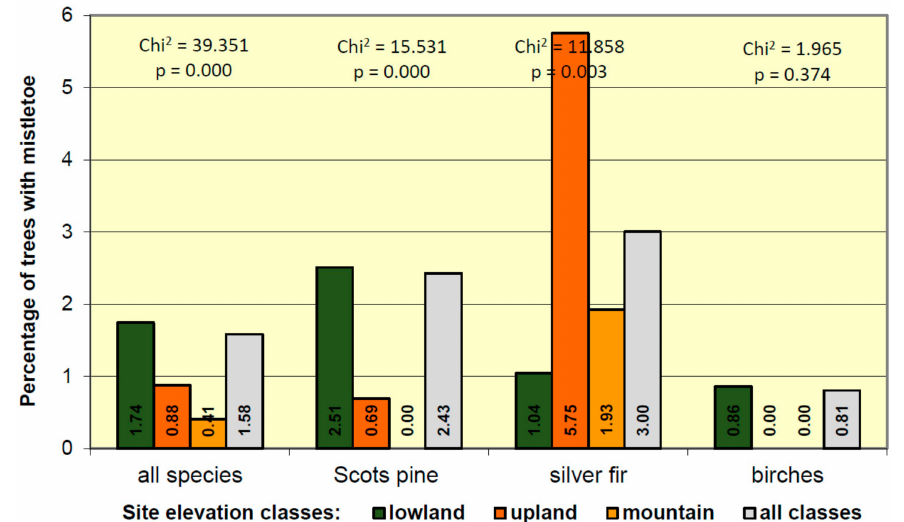
Figure 7. Percentage of trees with injuries caused by mistletoe in relation to elevation above sea level of sites were the plots were located and the results of the χ 2 test for independence for all trees together (all species) and separately for species most infested by mistletoe (Scots pine, silver fir, and